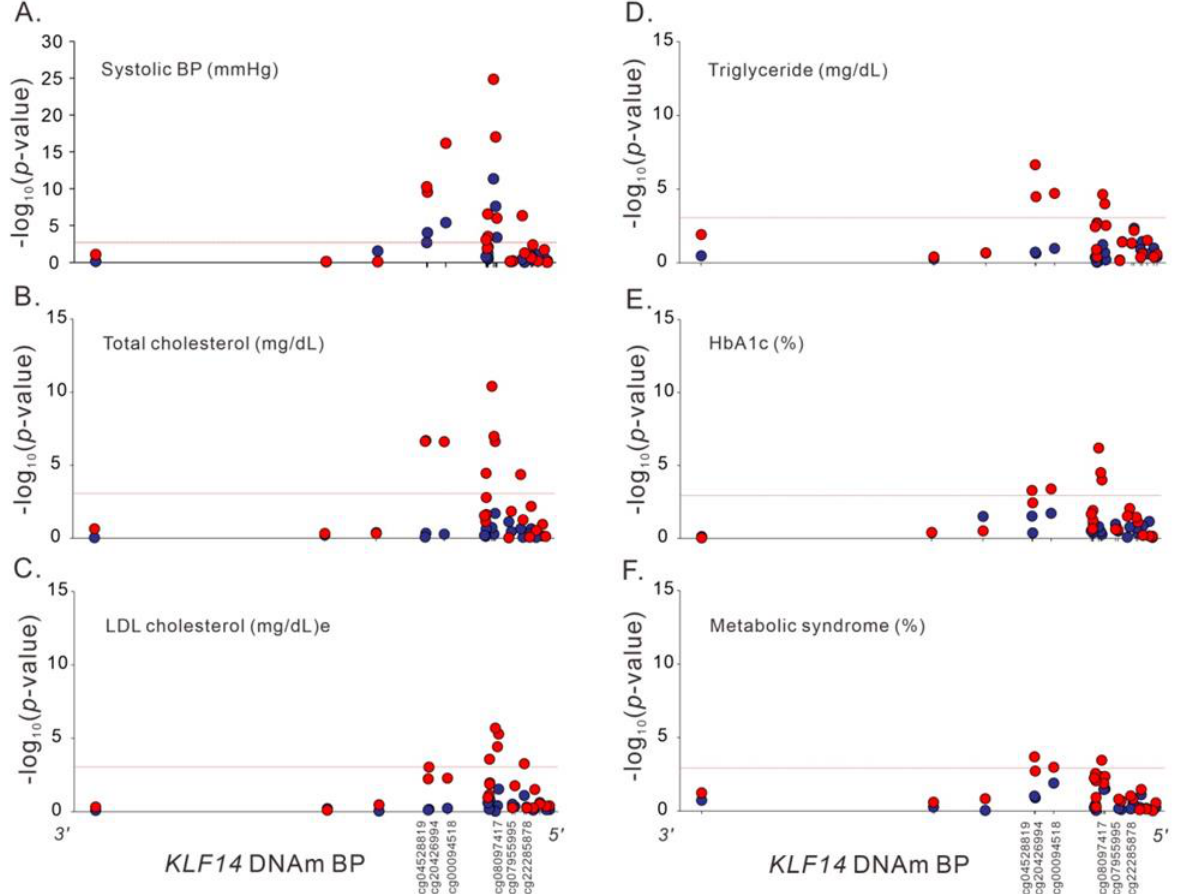
Figure 4. Regional plot association analysis between the studied phenotypes ( A ) Systolic BP, ( B ) Total cholesterol, ( C ) LDL cholesterol, ( D ) Triglyceride, ( E ) HbA1c, ( F ) Metabolic syndrome, and DNA methylation status according to sex, with red circles representing female participants and blue circles representing male participants.